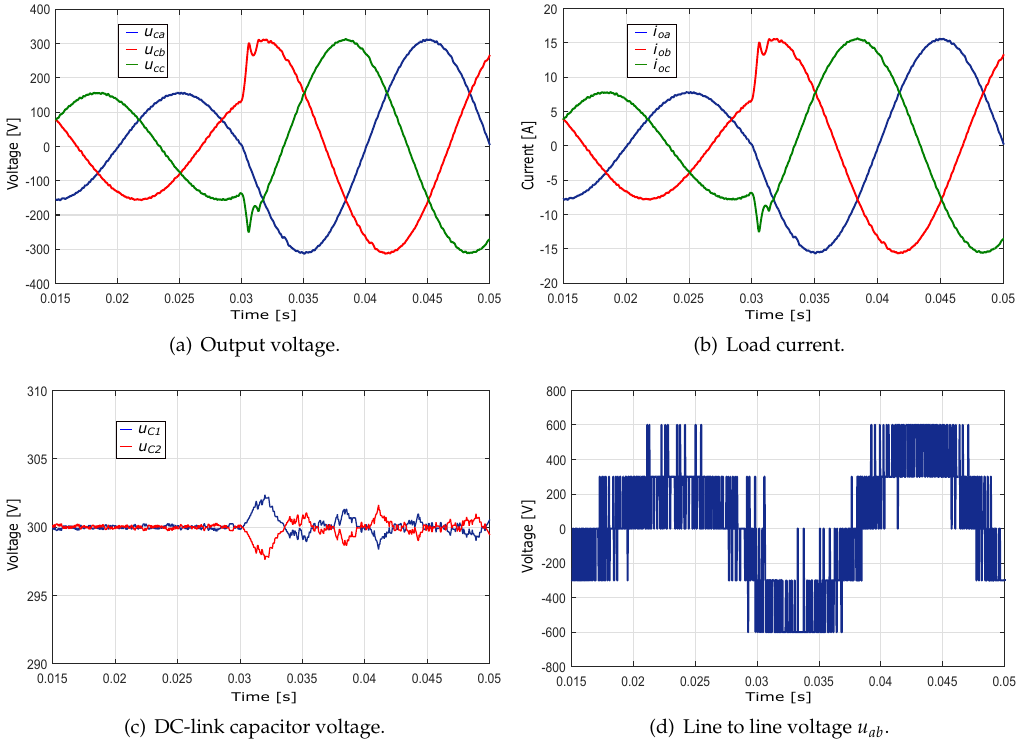
Figure 8. The dynamic response of the proposed method for step change from 155 to 311